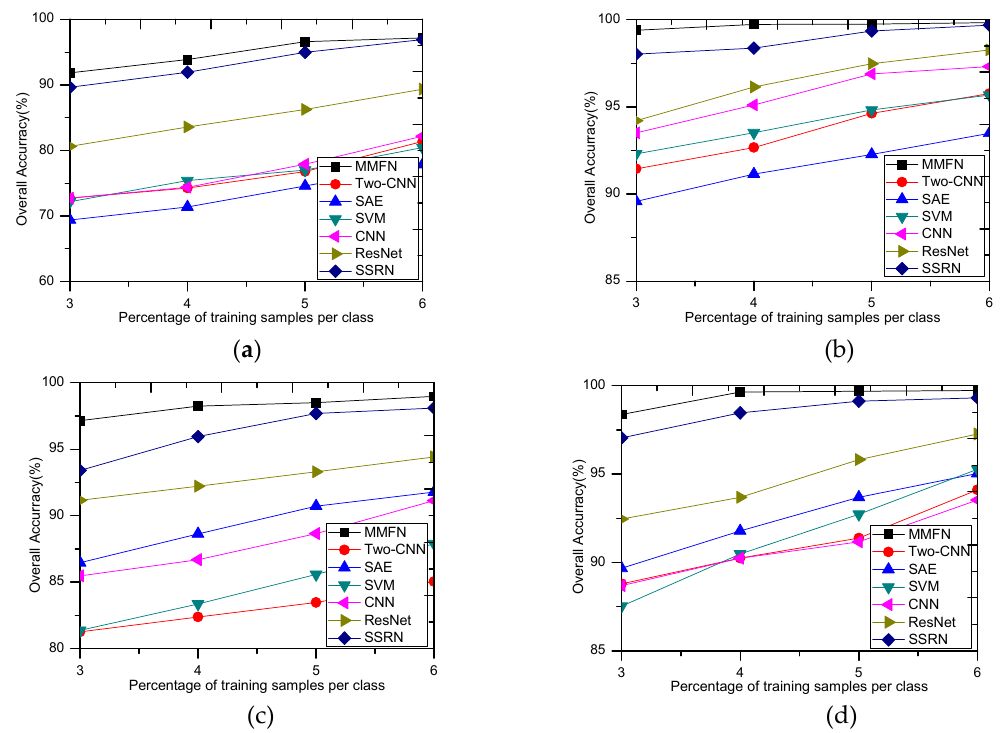
Figure 8. The Overall Accuracy of changing the percentage of training samples by all methods on the four data sets. ( a ) Overall Accuracy on IN. ( b ) Overall Accuracy on UP. ( c ) Overall Accuracy on KSC. ( d ) Overall Accuracy on Salinas. Table 8. Classification accuracies (%) of different methods on the four data sets.